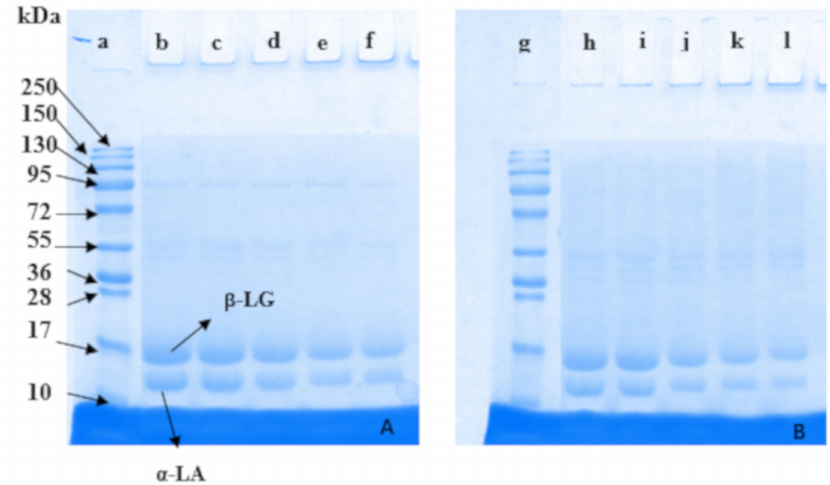
Figure 7. Protein profile of whey protein and inulin mixture before and after dry heating. ( A ) is untreated mixture and ( B ) is dry-heated mixture. a and g are Marker; b–f and h–l are samples at the ratios of whey protein to inulin of 3:1 to